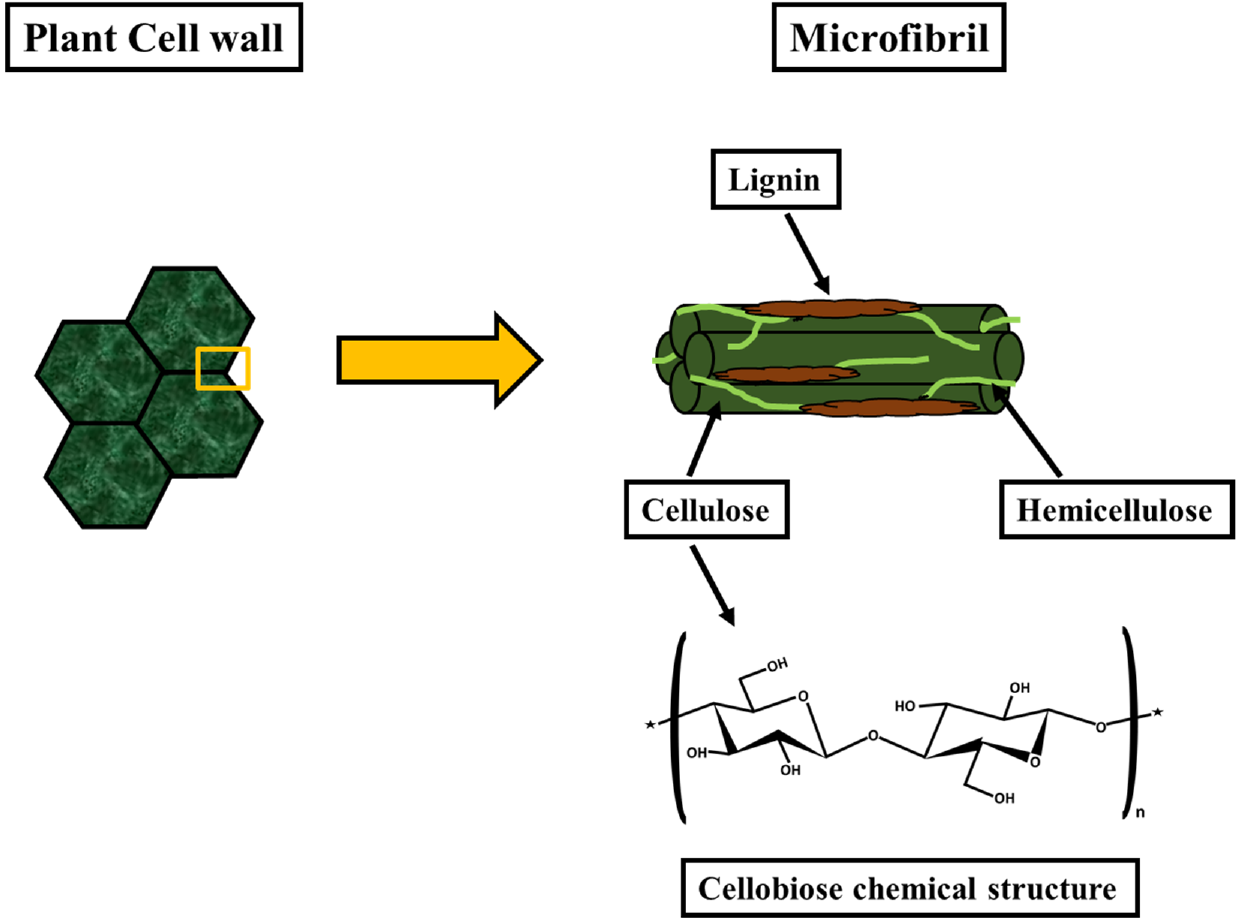
Figure 1. Plant cell wall structure and cellobiose chemical structure.